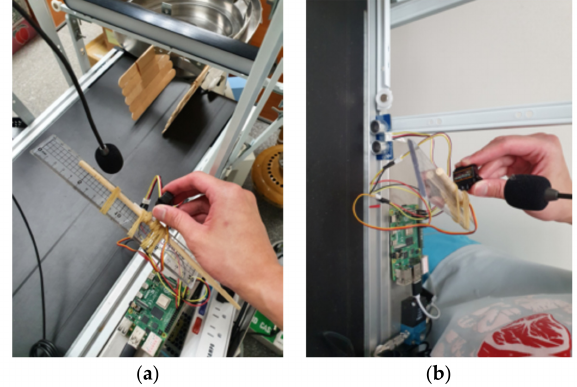
Figure 4. System developed in the lab: ( a ) top view, ( b ) side view.